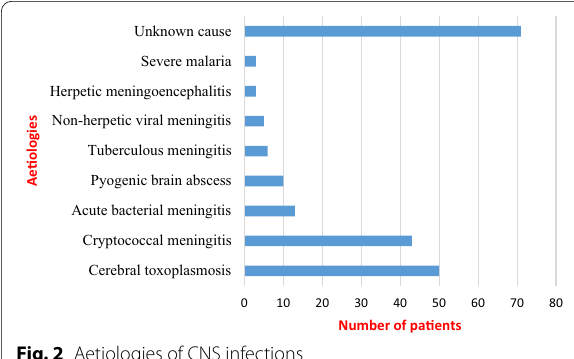
Fig. 2 Aetiologies of CNS